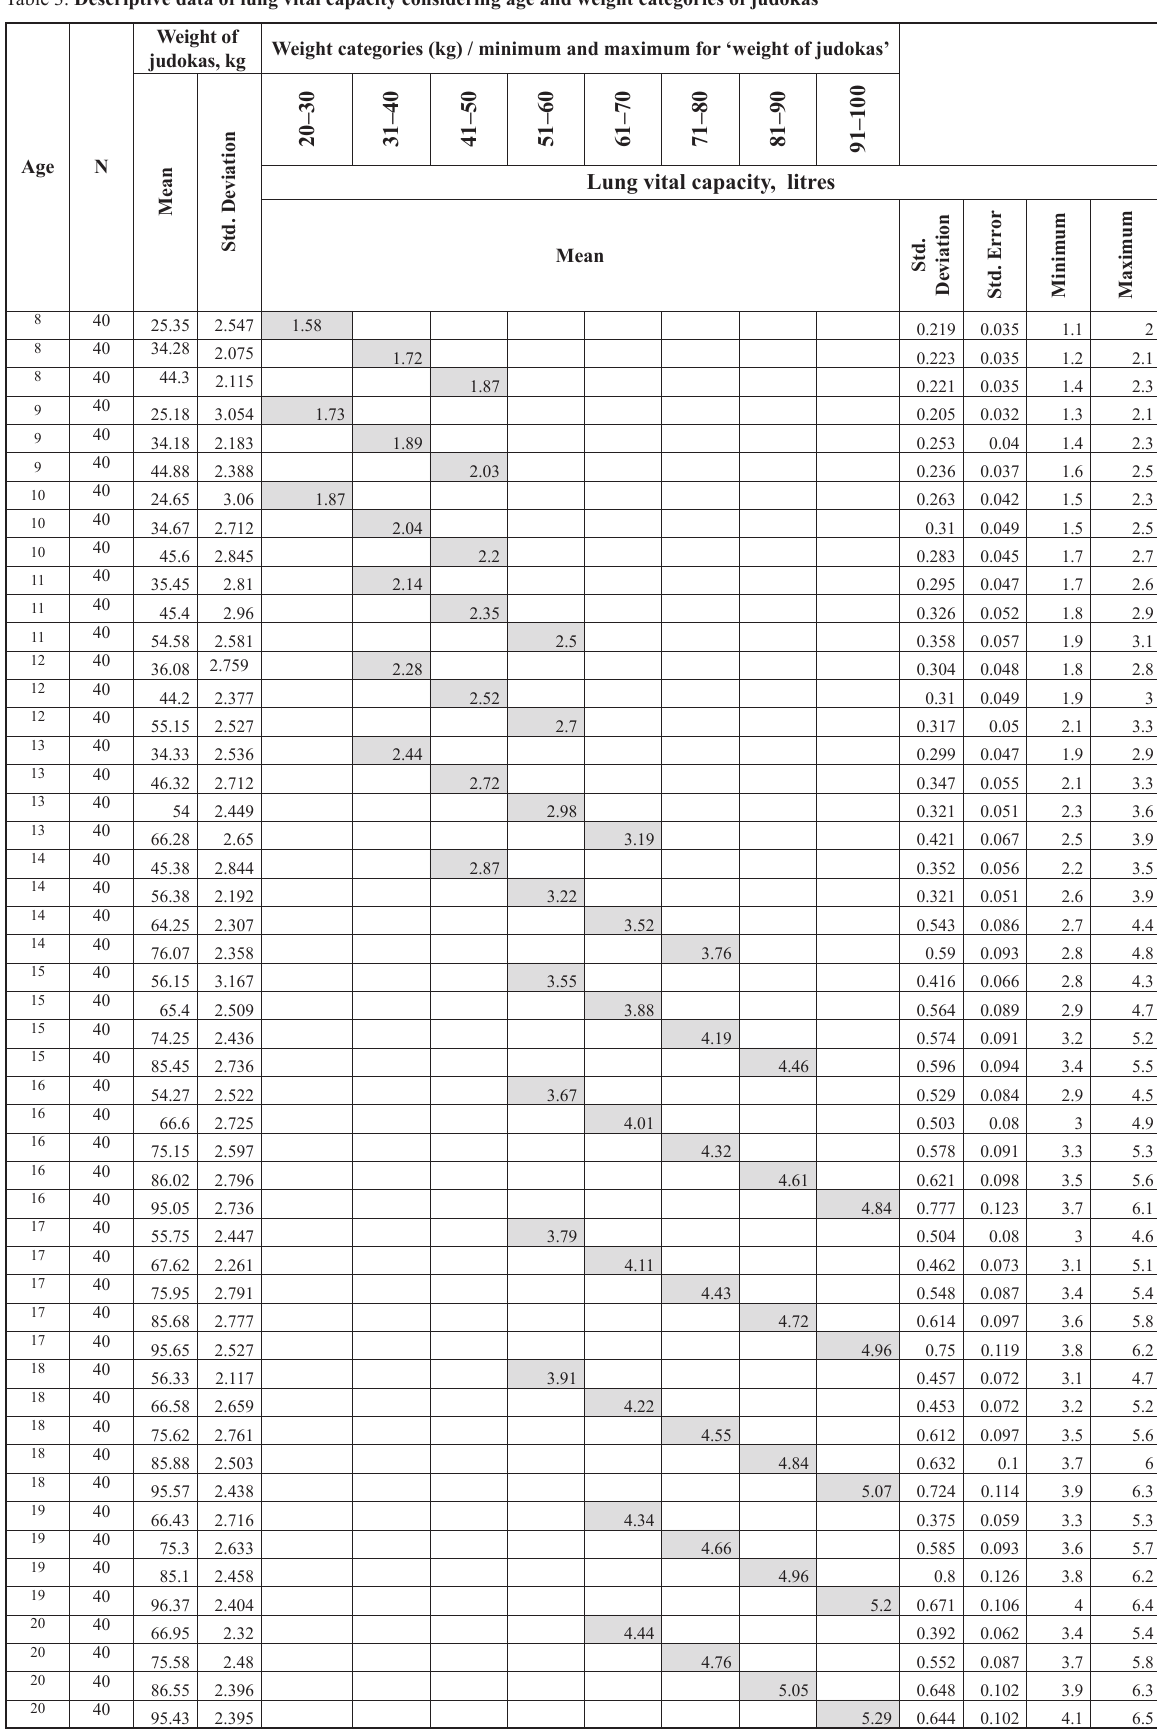
Table 3. Descriptive data of lung vital capacity considering age and weight categories of judokas Weight of Weight categories (kg) / minimum and maximum for ‘weight of judokas, kg